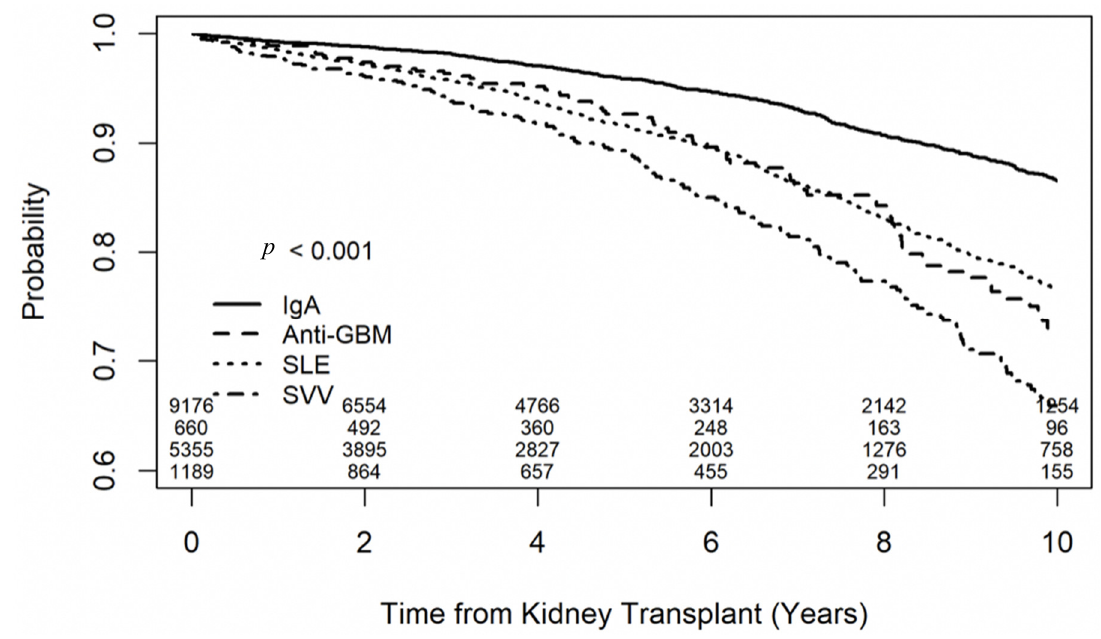
Figure 2. Recipient Survival by Glomerulonephritis Type.